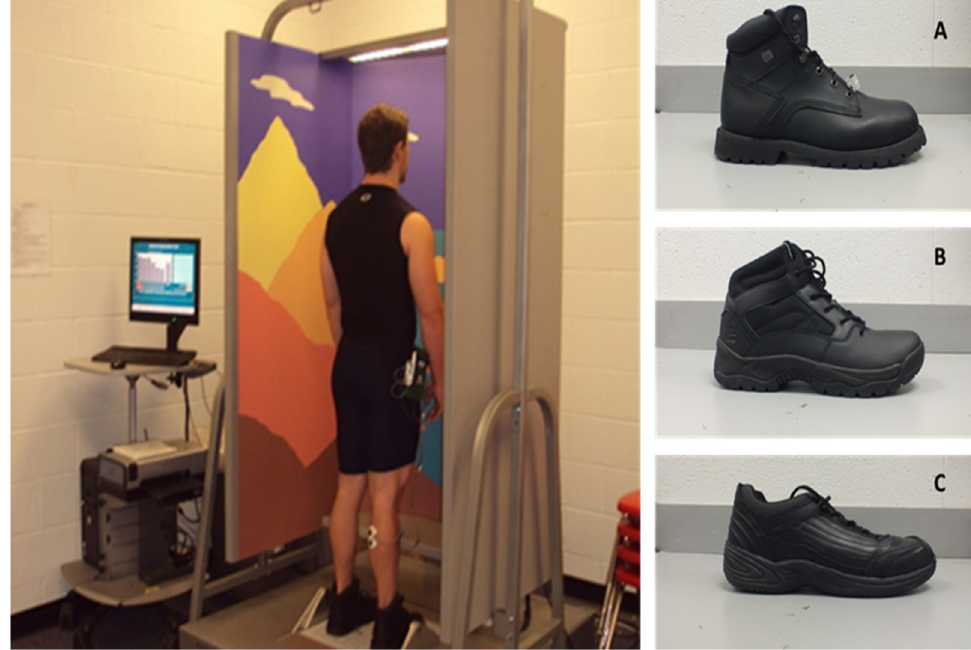
Figure 1. Sensory organization test (SOT) performed on the Neurocom Equitest™ with one of the types of occupational footwear tested (steel ‐ toed work boot). (A) steel ‐ toed work boot (ST); (B) tac ‐ tical work boot (TB); (C) low ‐ top slip ‐ resistant shoe